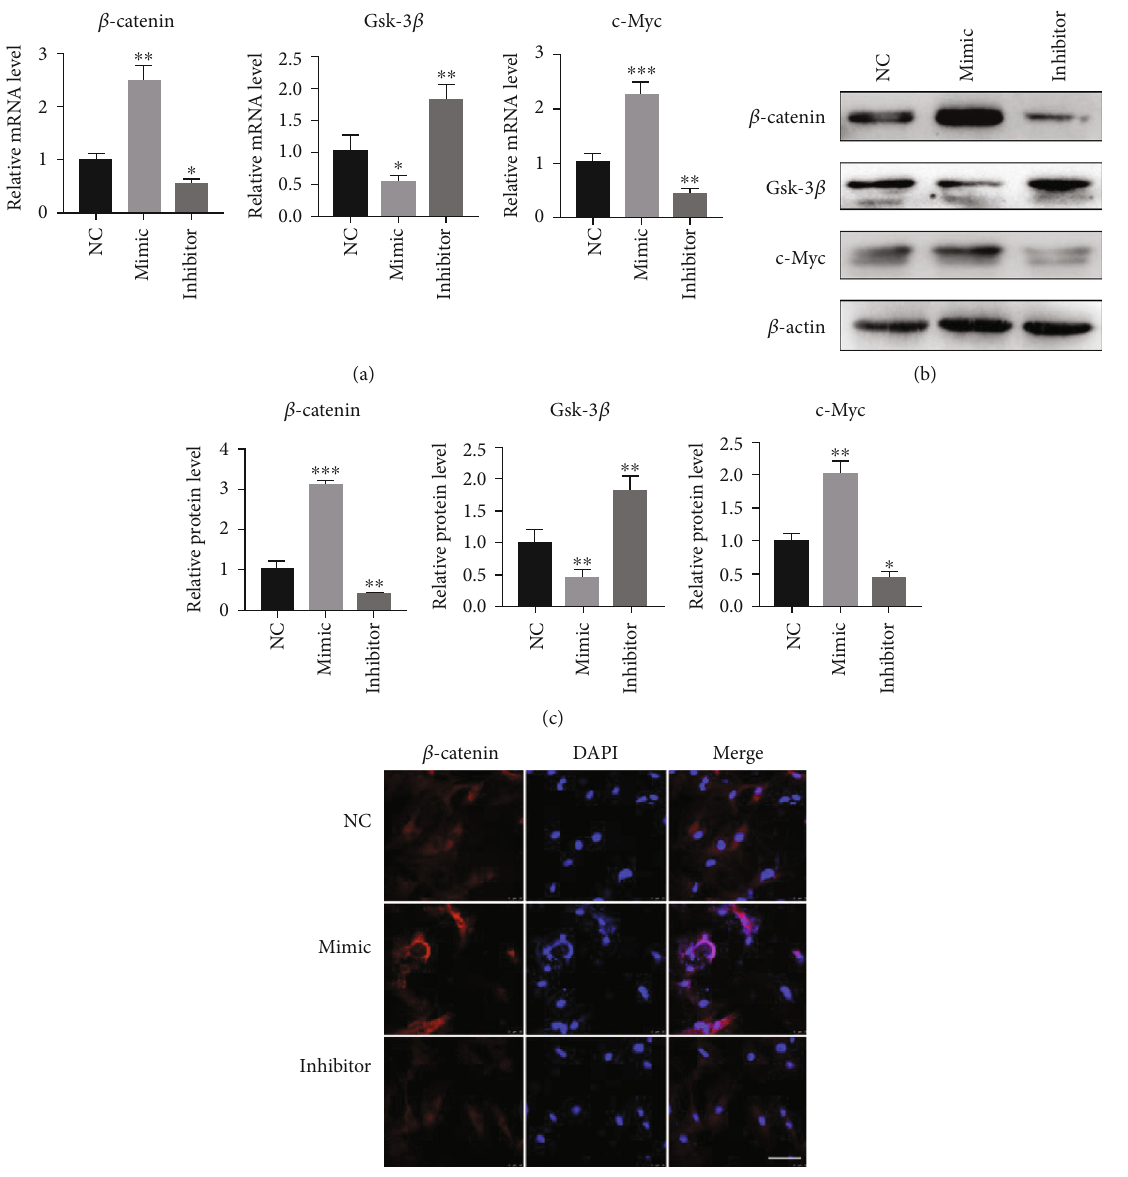
Figure 8: miR-129-5p activated the Wnt/ β -catenin pathway and its downstream transcription factors in BMSCs. The mRNA (a) and protein (b) expression of β -catenin, Gsk-3 β , and c-Myc were determined by quantitative RT-PCR and western blot in BMSCs transduced with a lentiviral vector containing miR-129-5p mimic, miR-129-5p inhibitor, or control (NC) lentivirus. (c) Quantitative analysis of protein expression levels of β -catenin, Gsk-3 β , and c-Myc. (d) Immuno fl uorescence assays showing the expression and location of β -catenin in the indicated BMSCs. Scale bars, 50 μ m. All assays were repeated at least three times. Data were shown as means ± SD ( n = 3